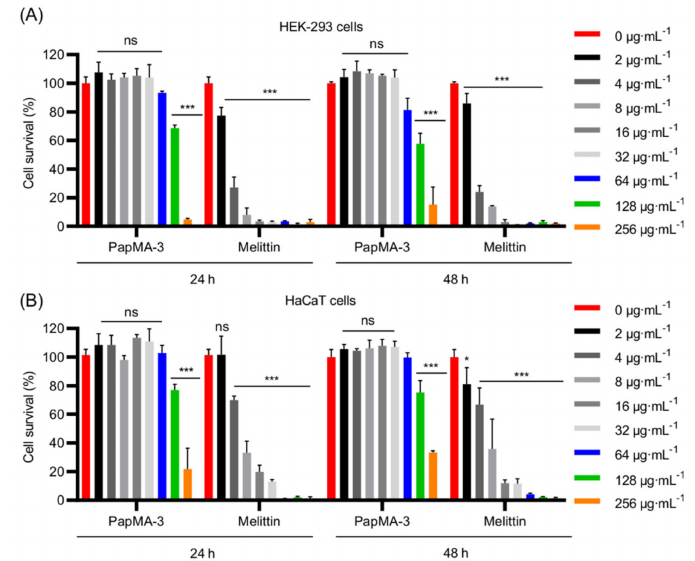
Figure 10. Cytotoxicity of PapMA-3 ( A ) Cytotoxicity of PapMA-3 against HEK-293 cells at 24 h and 48 h. ( B ) Cytotoxicity of PapMA-3 against HaCaT cell at 24 h and 48 h. Statistical analysis was